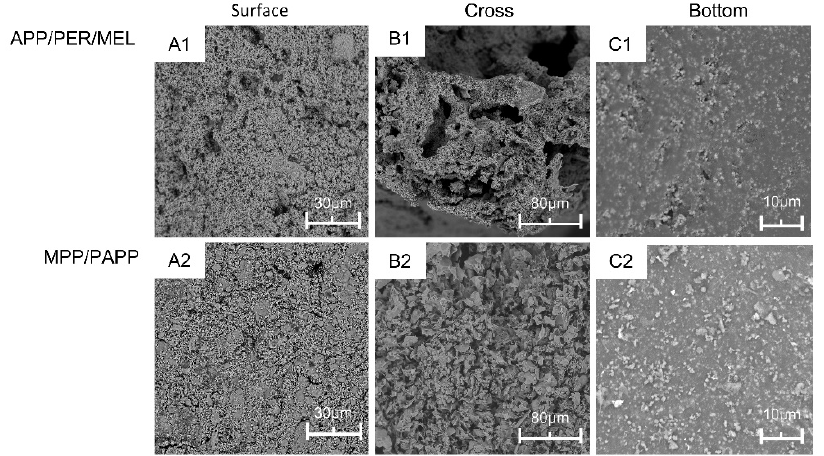
Figure 5. SEM images of the surface ( A1 , A2 ) layer, the cross-view ( B1 , B2 ), and the bottom ( C1 , C2 ) layer of the chars. layer of the